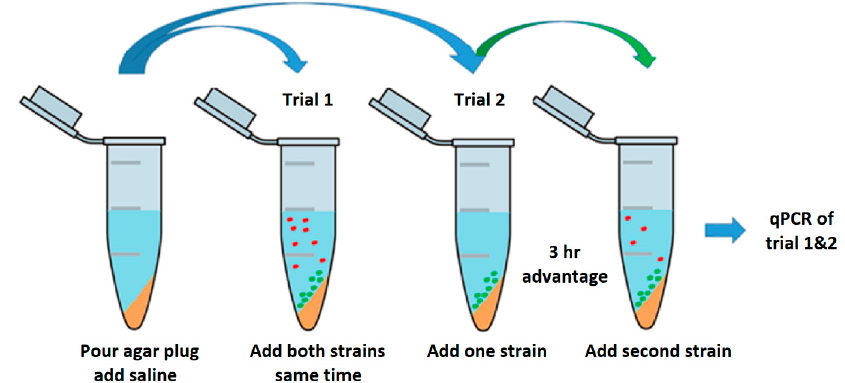
Figure 3. Schematic of Plug ‘n’ Prey. A 2 mL tube prepared with slants of 200 µL MAC agar. Slants